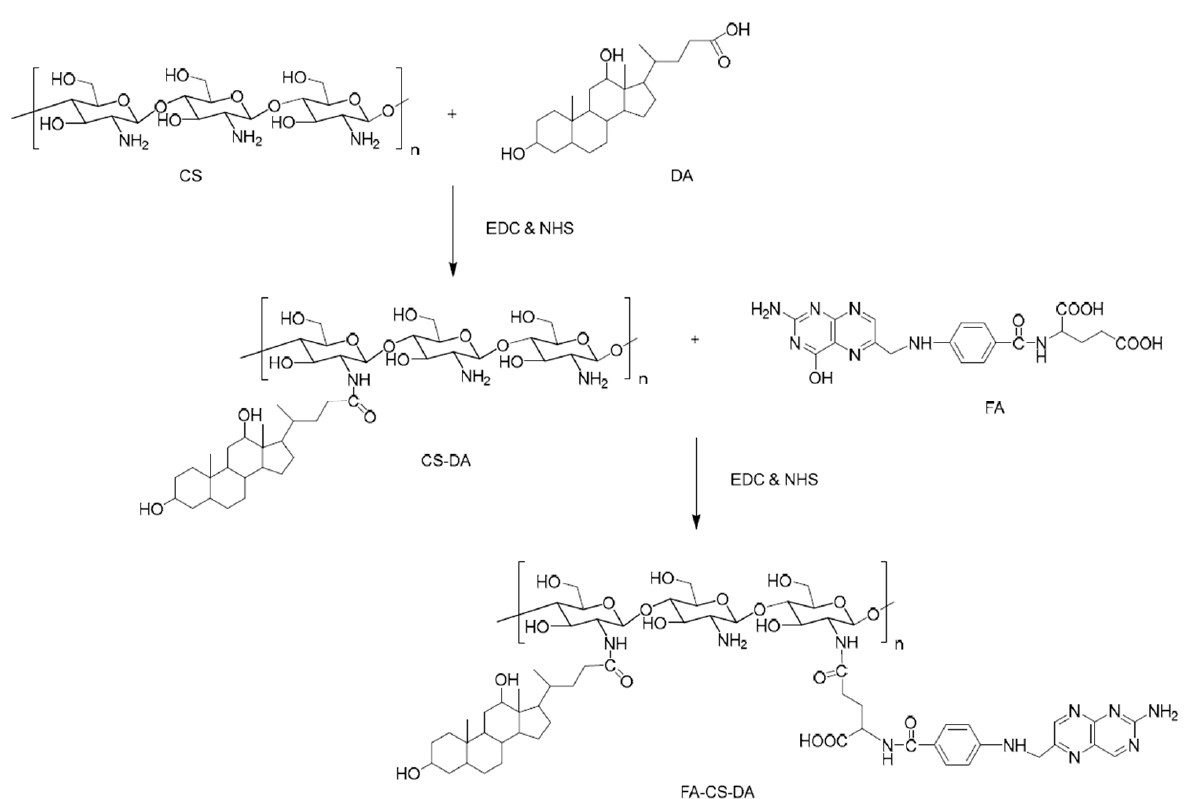
Figure 6. Schematic synthesis route of folic acid (FA)–CS–deoxycholic acid (DA) copolymer